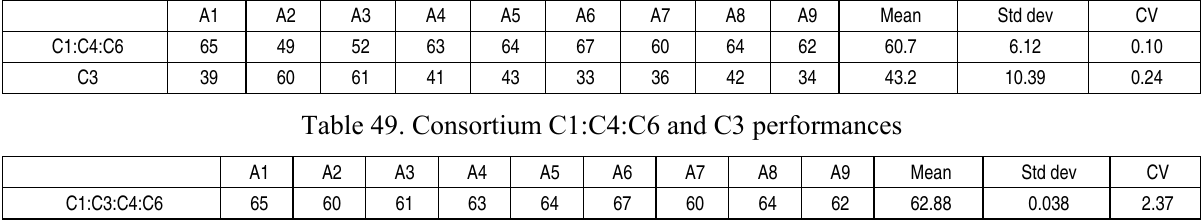
Table 48. Performances of consortium C1:C4:C6 and C3